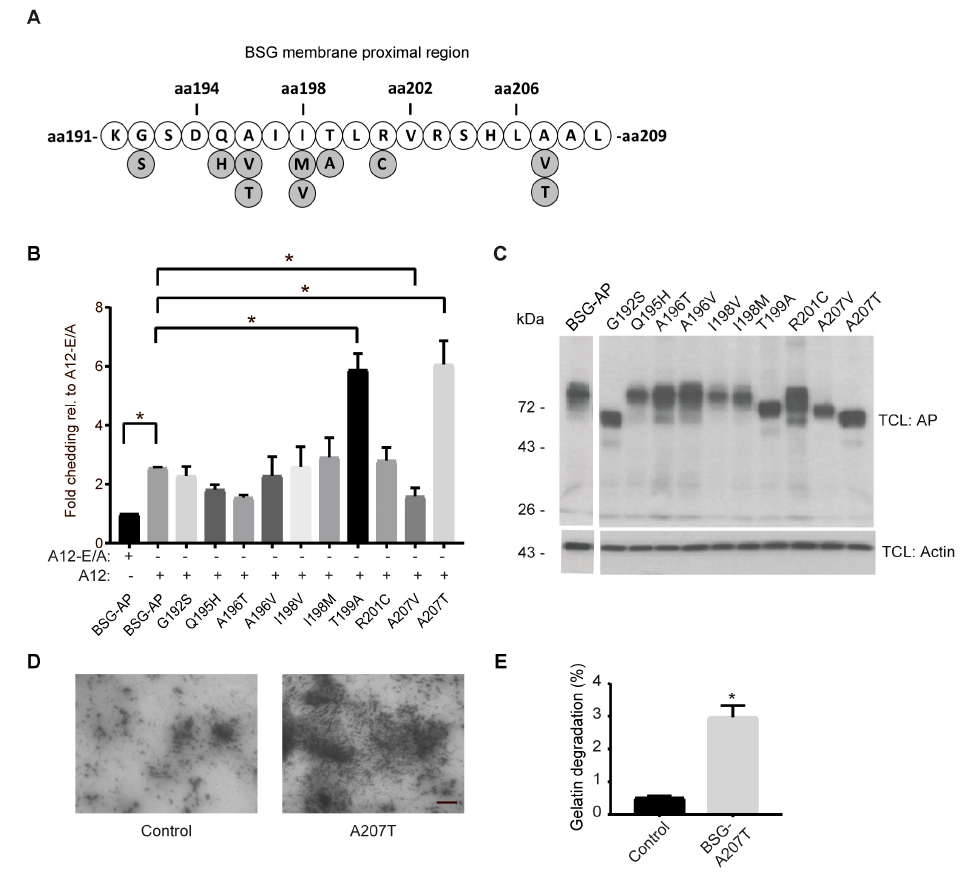
Figure 5. Cancer-associated BSG mutants are di ff erentially shed by ADAM12. ( A ) Illustration of cancer-associated mutations (marked in grey) in the extracellular membrane proximal region (aa. 190–208) of BSG, identified in the Catalogue Of Somatic Mutations In Cancer (COSMIC) database (BSG, ENST00000333511; August 2017). ( B ) Fold shedding in 293-VnR cells transfected with A12 or the catalytically inactive A12-E / A mutant together with wildtype (BSG-AP), or various BSG-AP point mutations identified in ( A ). ( C ) Western blot of AP in total cell lysates (TCL) from cells in ( B ). Actin was used as loading control. ( D ) In situ gelatinase assay, using HT1080 cells grown on Oregon green-labeled gelatin and treated with conditioned media from untransfected 293-VnR cells (control) or 293-VnR cells transfected with ADAM12 together with a full-length BSG expression construct harboring the A207T mutation. Dark areas (without green fluorescence) represent gelatin degradation, scale bar = 10 µ m. ( E ) Gelatin degradation was measured in µ m 2 for 27 images, using MetaMorph software and the percentage degradation was calculated. For both graphs, values represent means ± SEM from three independent experiments. * p < 0.05, Student’s t -test or